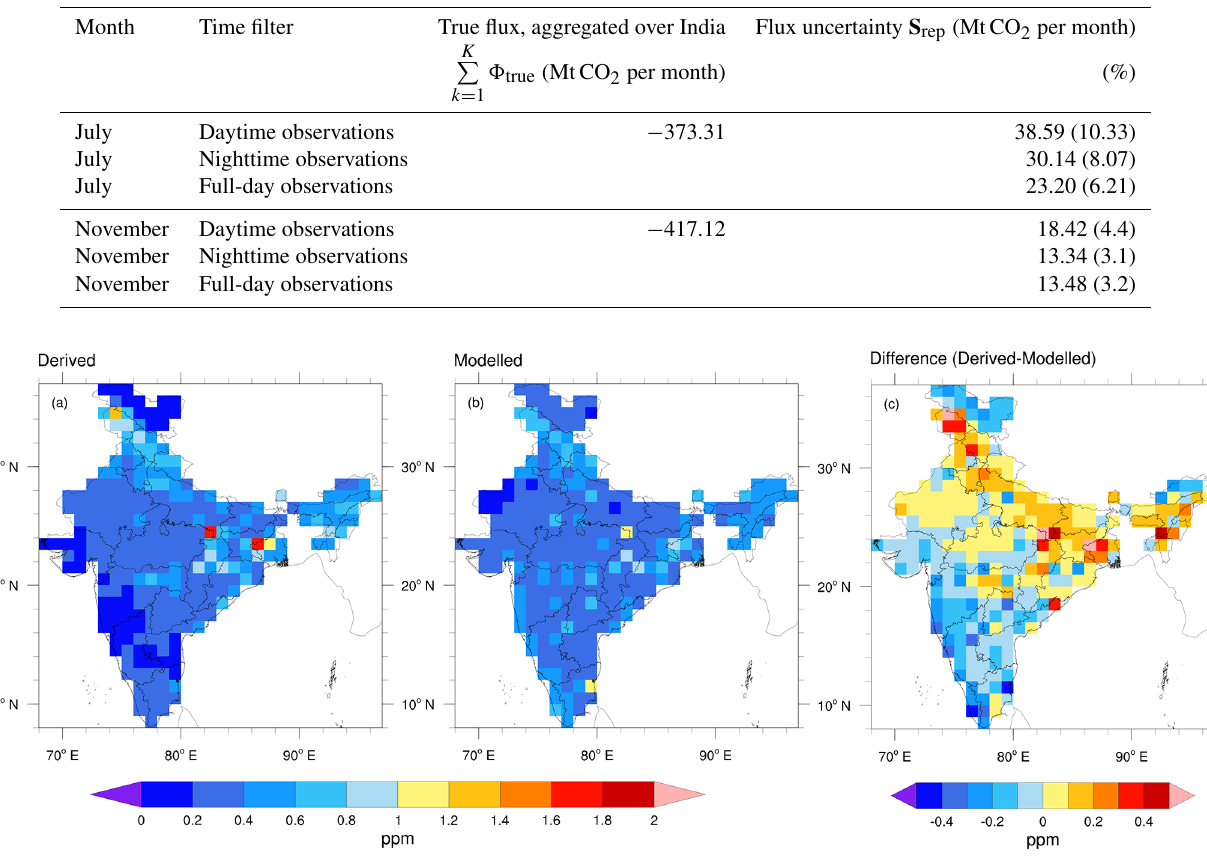
Figure 9. Monthly averaged values of representation error estimated for column-averaged CO 2 concentration during the July daytime (11:30 to 16:30LT) in 2017. (a) Representation error derived from WRF-GHG simulations, as explained in Sect. 2.3. (b) Representation error calculated from the multivariate linear model, as described in Sect. 3.5. (c) Difference between panels (a) and (b)